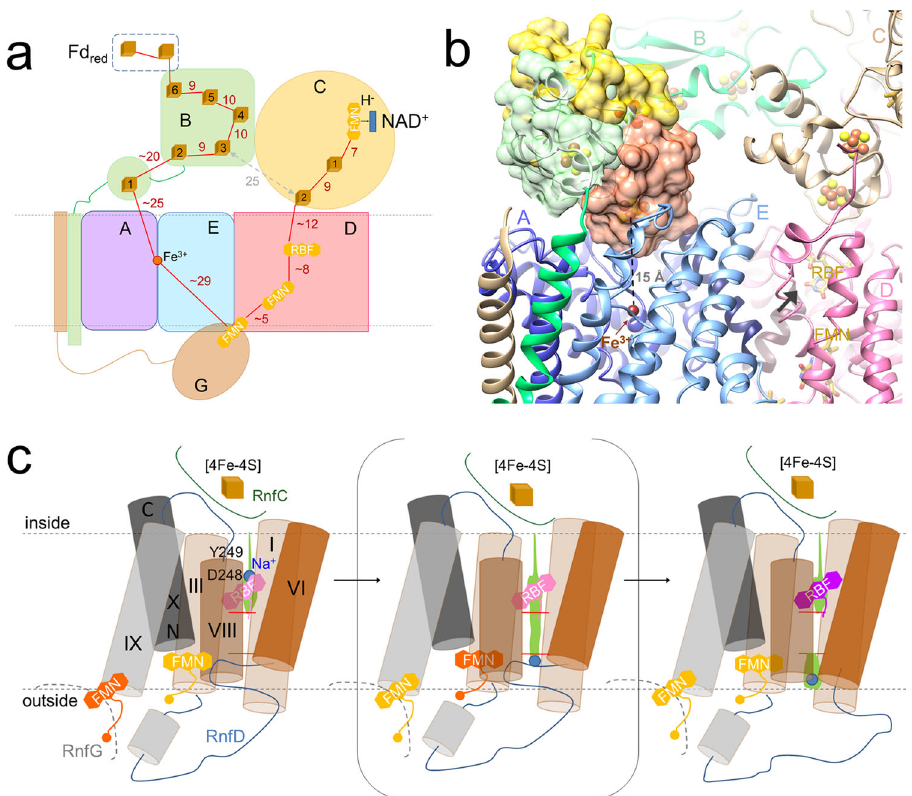
Fig. 7 | Mechanism of Rnf. a Scheme of the ET pathway (highlighted as red lines). The electron fl ows from the reduced cytoplasmic Fd-like protein (dashed rec- tangle) modeled in contact with RnfB via RnfB and the membrane-spanning RnfAE totheextracellularRnfGandfromtherebackviaRnfDandRnfCtoNAD + .The[4Fe- 4S] clusters are shown as brown cubes and the fl avins as yellow triplex-hexagons. The shortest distance between electron carriers of RnfB and RnfC is 25Å (gray). b ET from [4Fe-4S] RnfB-2 to Fe RnfAE via Fe RnfB-1 . FdI (in surface representation) is drawn in green in the position found in the EM structure, in yellow in the position obtained from an Alphafold2 model of RnfB and in coral in the manually modeled position attached to RnfAE. The [4Fe-4S] cluster is shifted ca. 15Å from the Alphafold2 to the modeled position. The C-terminal helix of RnfAE (dark blue) contactingFdIinteractswithhelix126:136(V)ofRnfD(purple)thatmightbepartof